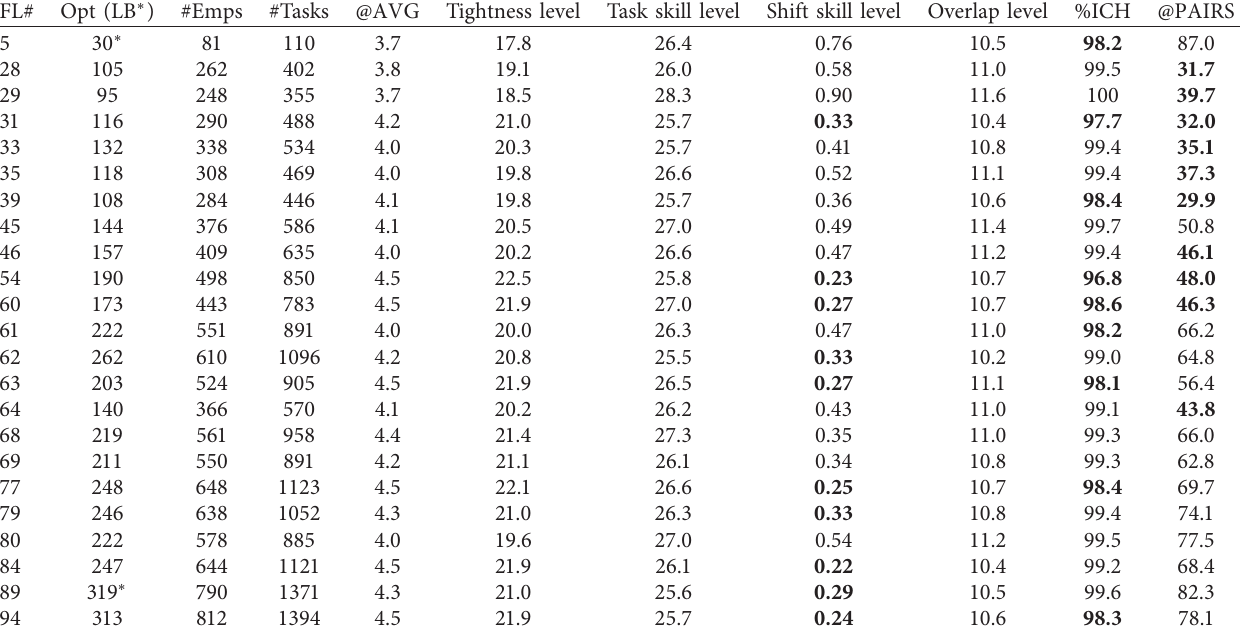
Table 3: The characteristics of the 23 FL